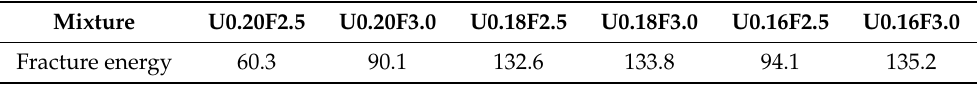
Table 5. The fracture energy of the UHPC samples (J/m 2 ).